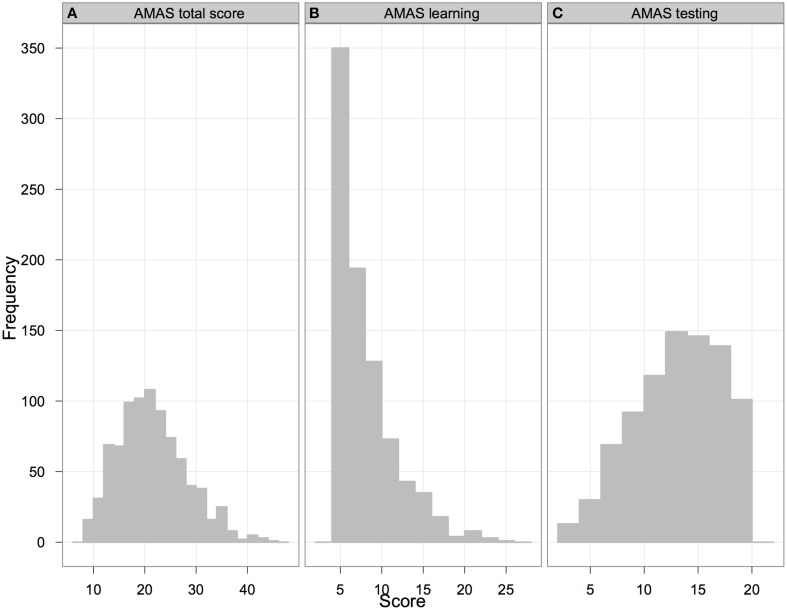
Distribution of AMAS total (panel A) and scale totals (panels B and C for Learning and Testing scales respectively). The score-range for the AMAS total is from 9 to 45, for the Learning scale from 5 to 25, for the Testing scale from 4 to 20.